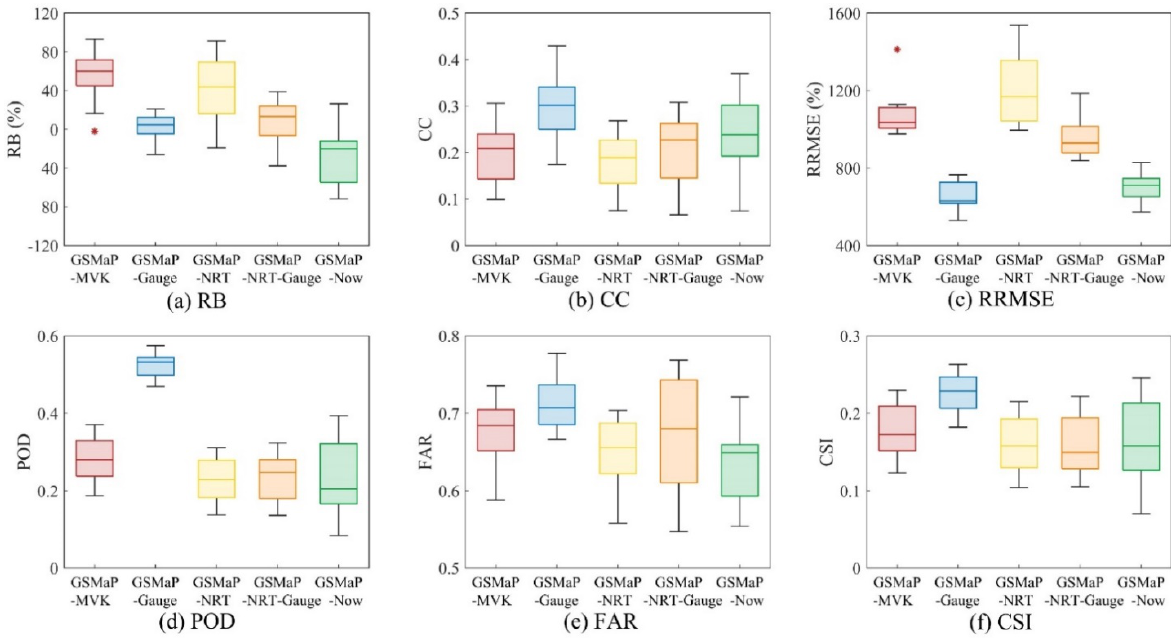
Figure 6. Box plot of the statistical indices of hourly precipitation estimates from the five GSMaP SPPs at the 13 weather